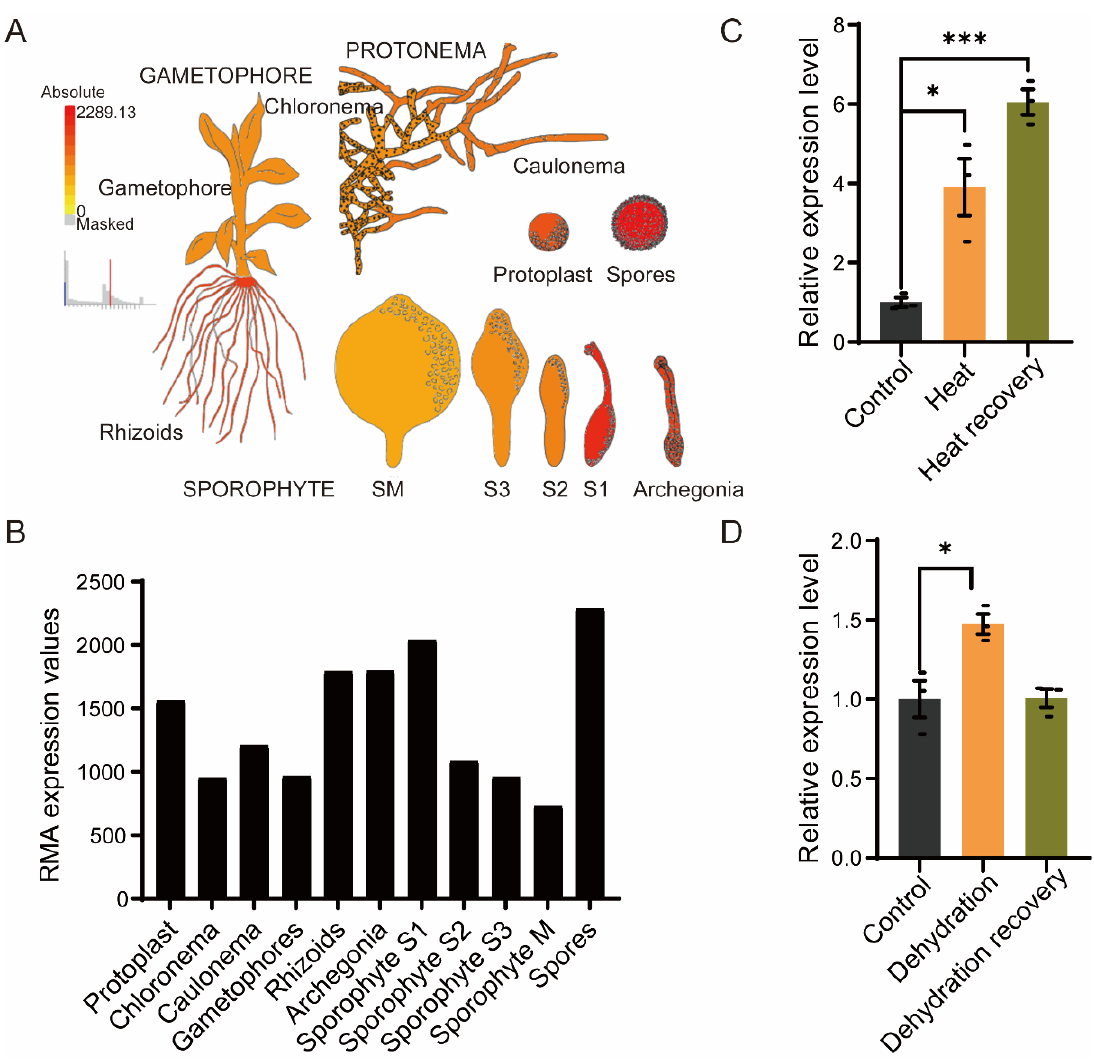
Figure 2. Gene expression patterns of PpRNH1A throughout the life cycle of P. patens and the expression levels under different stresses. ( A ) Visualization of the expression of PpRNH1A at different tissues during P. patens growth and development. ( B ) The RMA expression values of PpRNH1A at different periods of growth and development. Data were downloaded from Physcomitrella eFP Browser. ( C ) Gene expression levels of PpRNH1A under heat stress and after heat recovery. ( D ) Gene expression levels of PpRNH1A under dehydrating stress and after recovery. For ( C , D ), data are presented as means ± SEM of three replicates; t -test was used for statistics; asterisks indicate the significant difference between treatment group and the control group, * p < 0.05, *** p < 0.001.